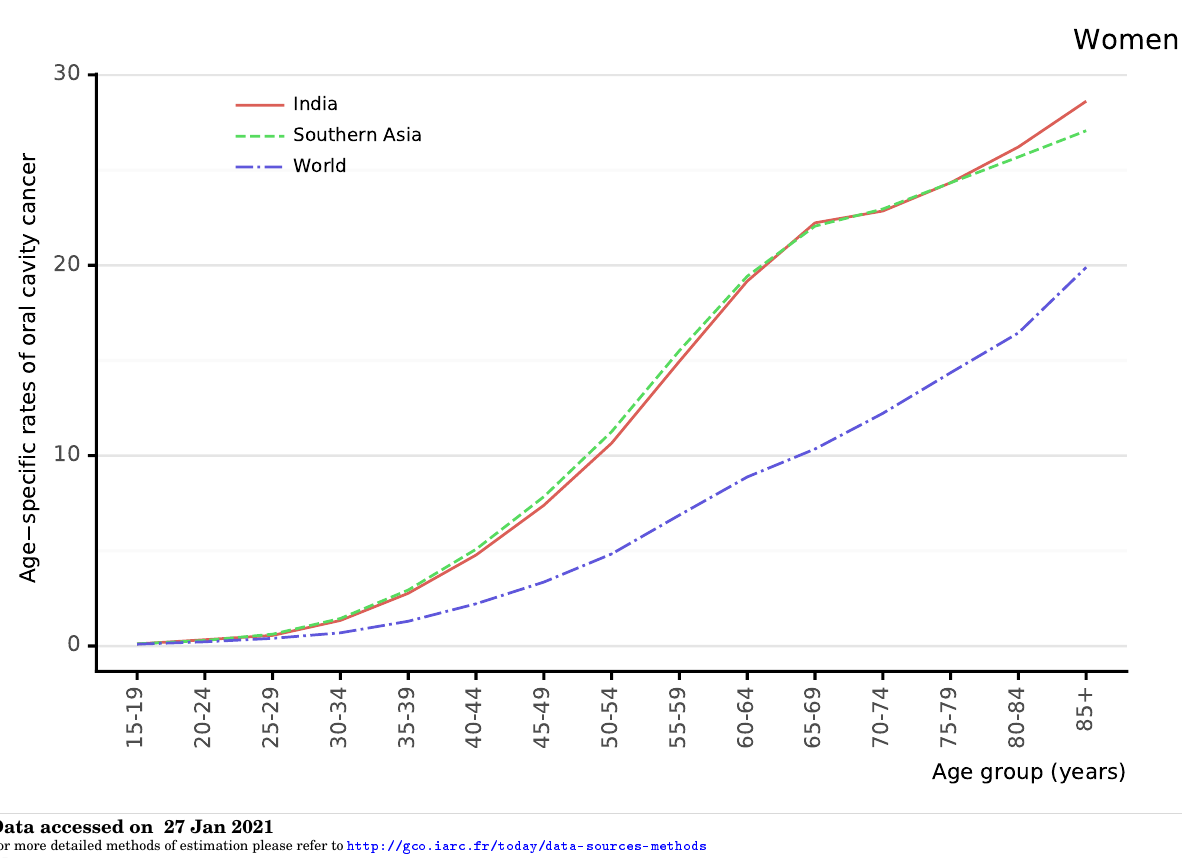
Figure 99: Comparison of age-specific oral cavity cancer incidence rates among women by age in India, within the region, and the rest of